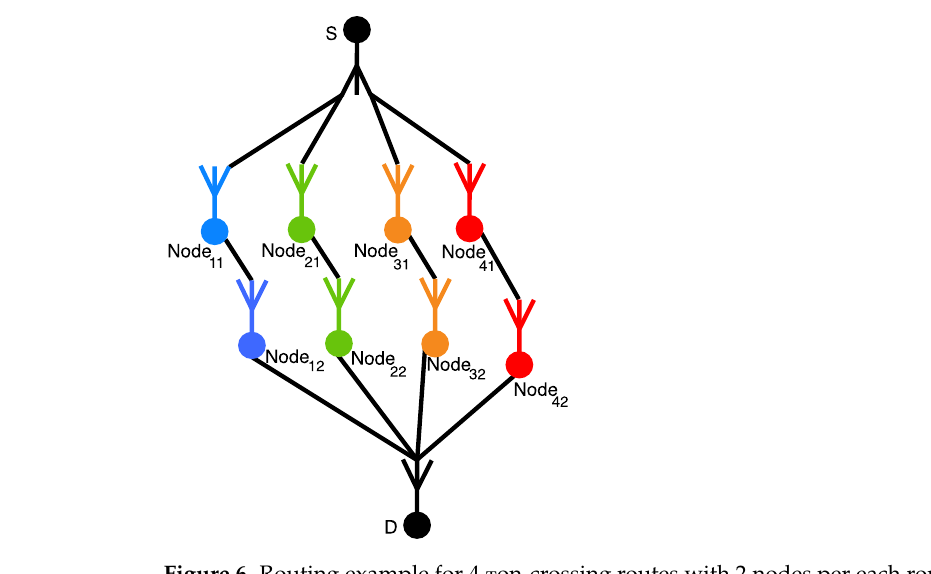
Figure 6. Routing example for 4 тon-crossing routes with 2 nodes per each route.